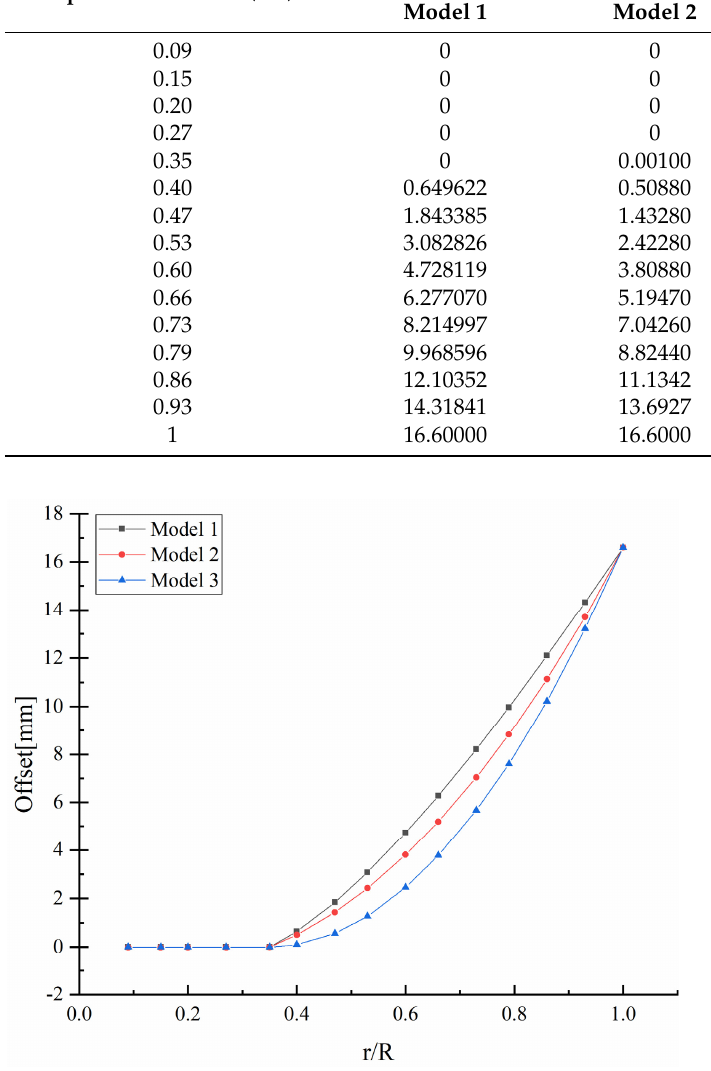
Figure 5. Offset comparison of different models.